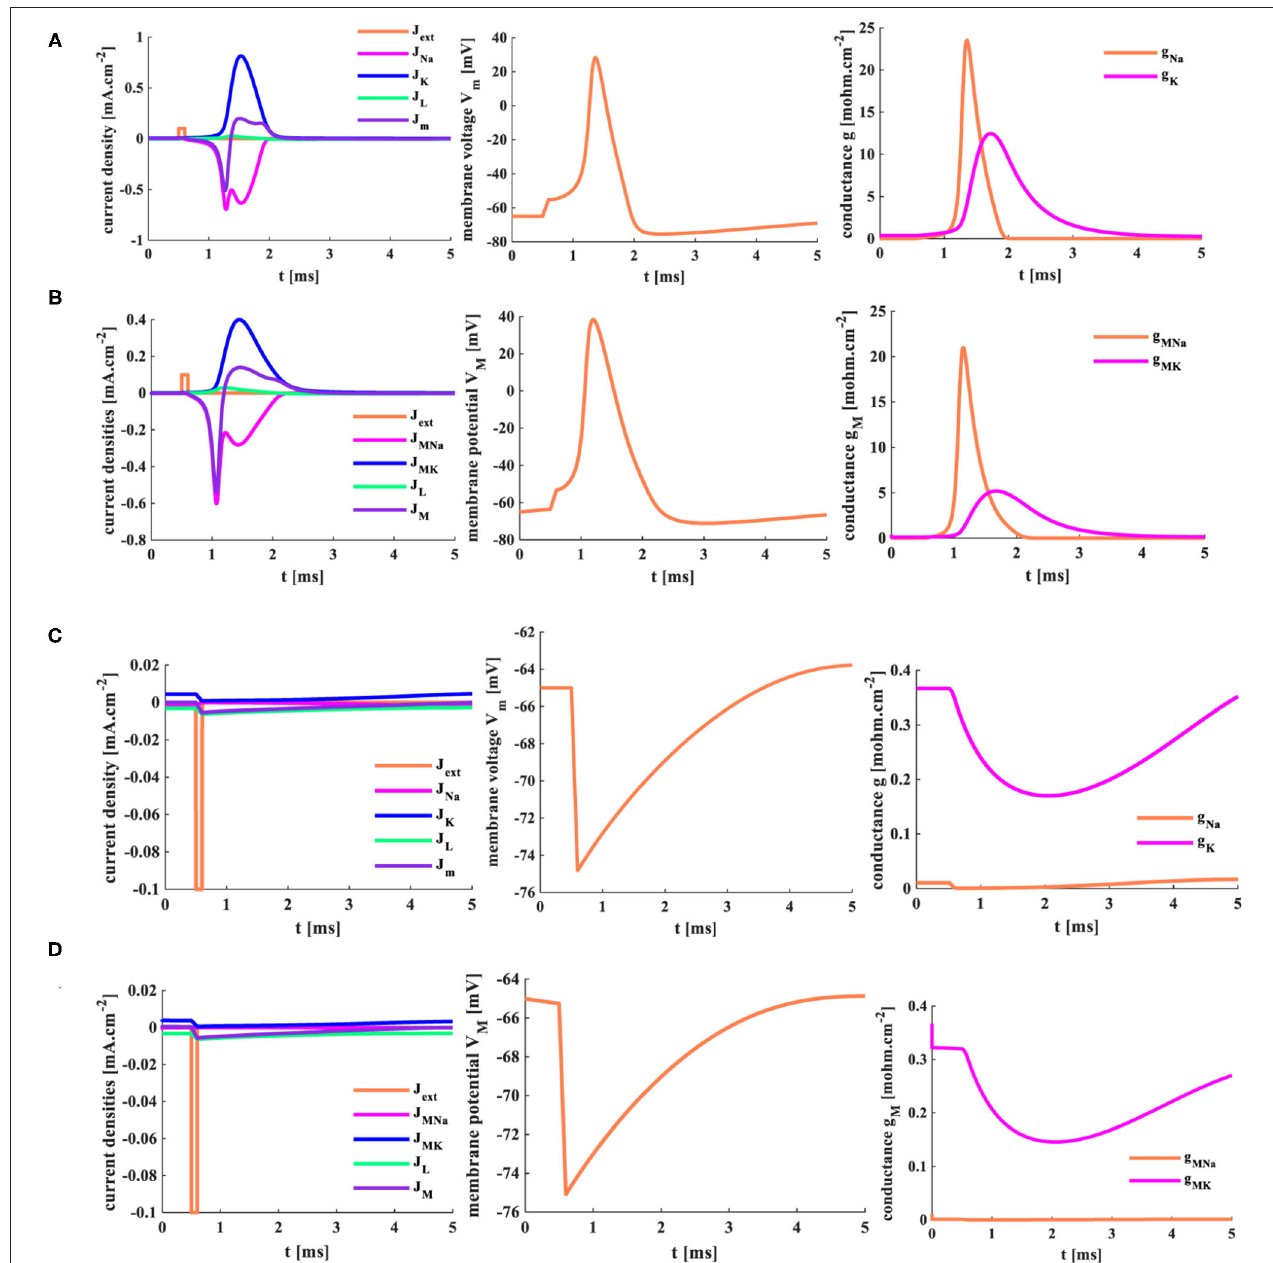
FIGURE 11 | The single pulse and the reverse pules are applied to two models. (A) The single current pulse is injected into the HH spiking model. (B) The single current pulse is injected into the MHH spiking model. (C) The reverse current pulse is injected into the HH spiking model. (D) The reverse current pulse is injected into the MHH spiking